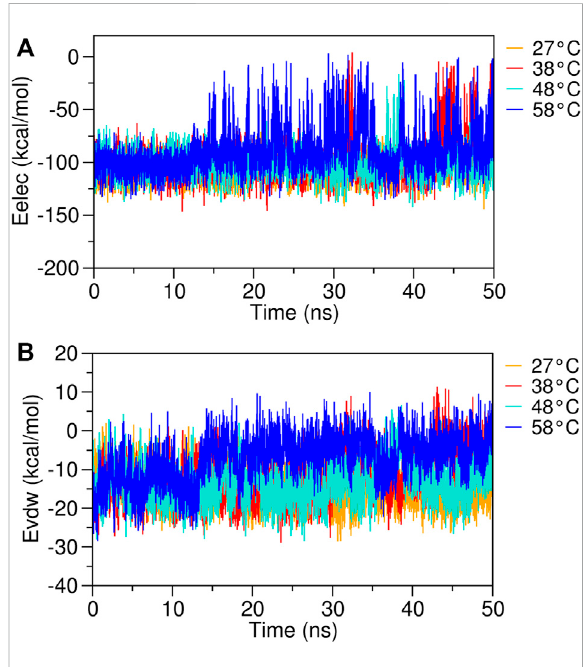
FIGURE 7 RMSD plots of the eugenol – β -cyclodextrin complex were obtained from different temperatures. (A) electrostatic energy (Eelec)and (B) vanderWaalsenergy(Evdw)complexanalyzedover 50 ns of MD simulation at 27 ° C, 38 ° C, 48 ° C, and 58 ° C.